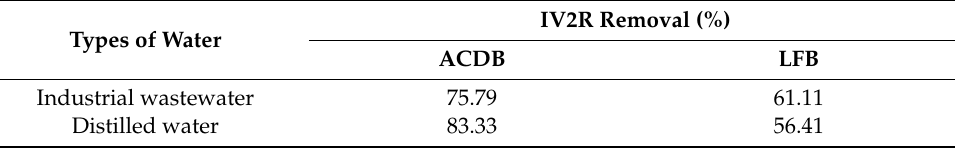
Table 5. Percentage of removal for IV2R dyes by using ACDB and LFB in a different water sample.